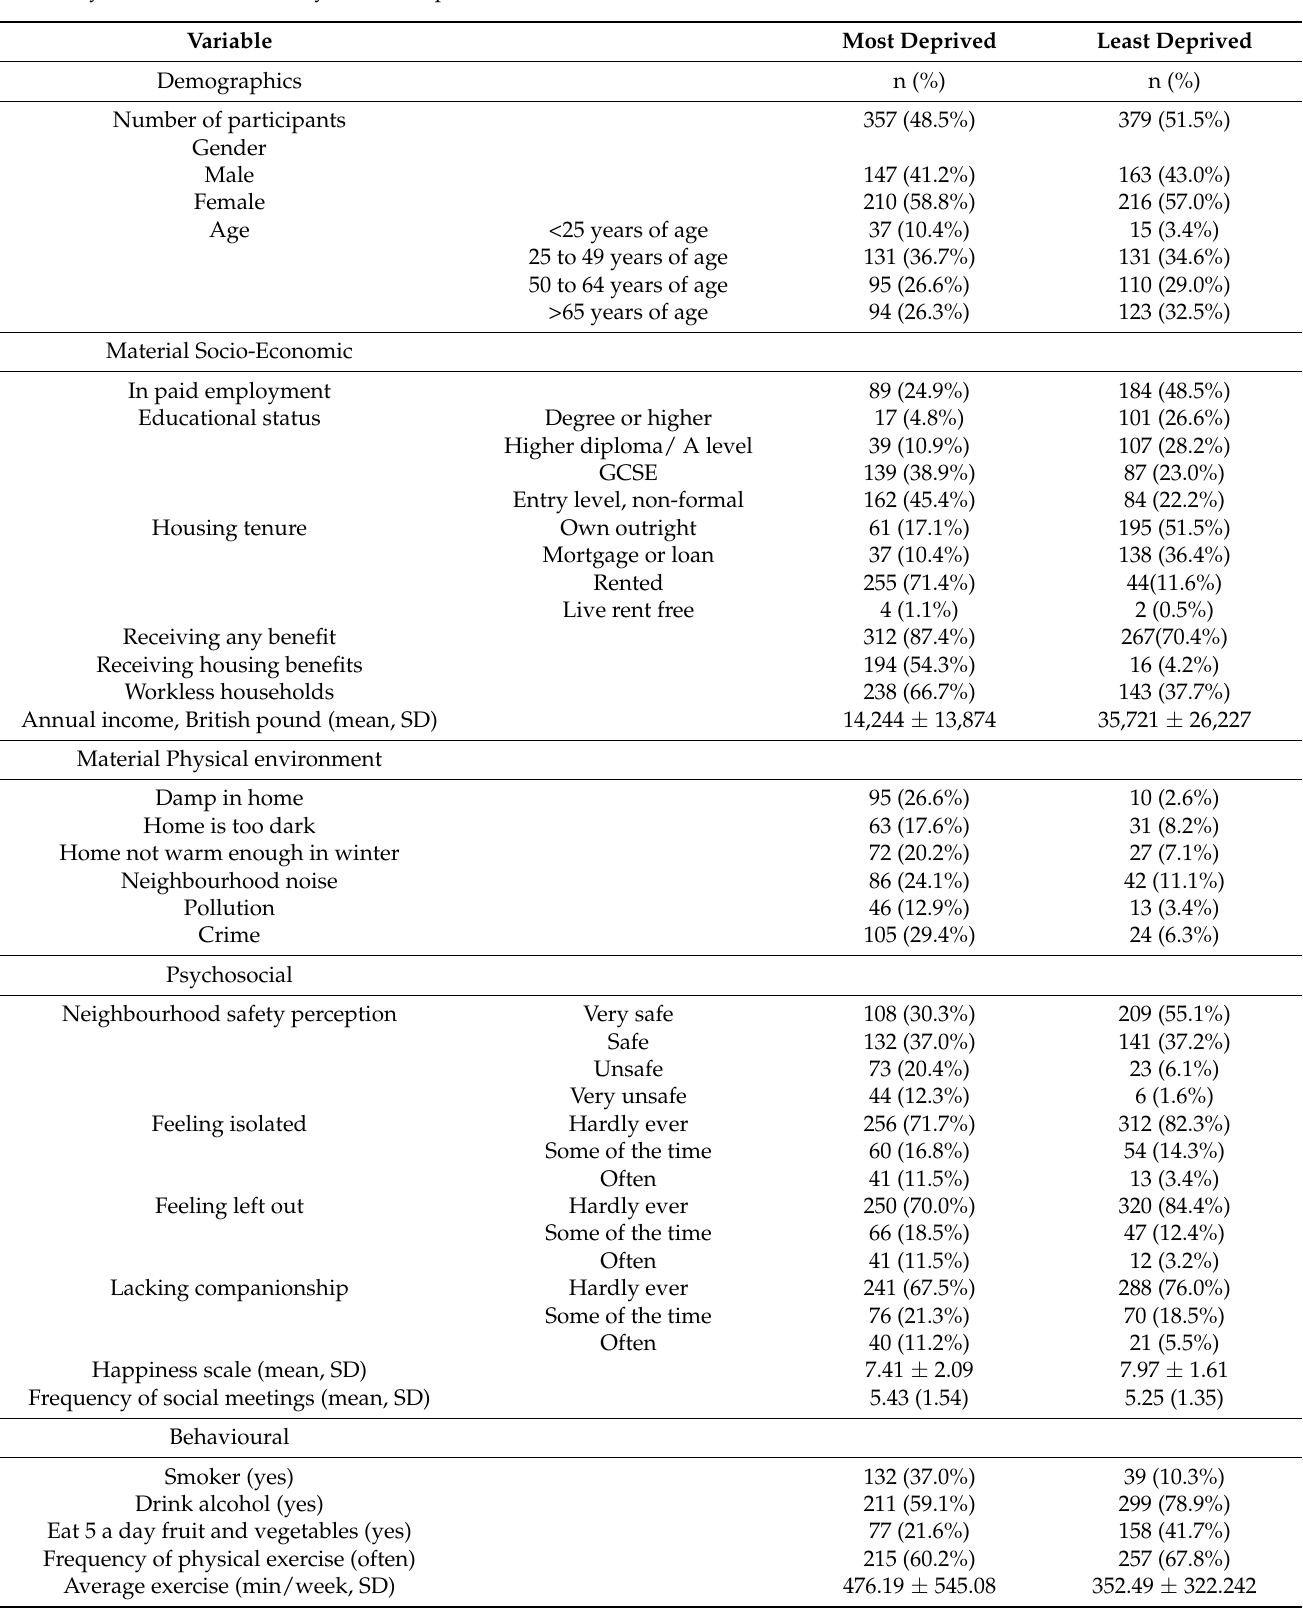
Table 1. Baseline descriptive analysis of demographic, material, psychosocial, contextual and behavioural variables in the analysis cohort, stratified by level of